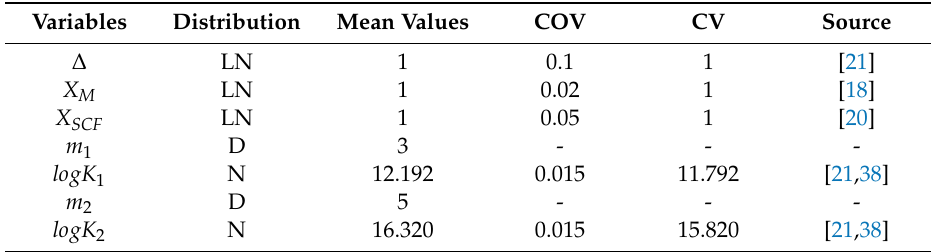
Table 1. Partial parameters of stochastic variables. (D: deterministic, CV: characteristic value, COV: coe ffi cient of